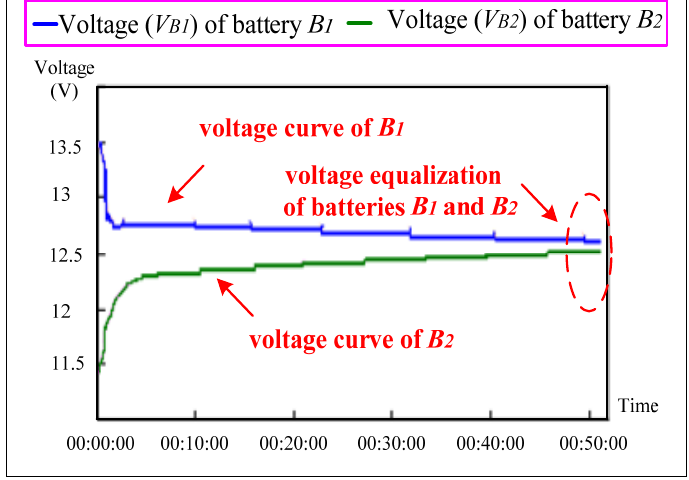
Figure 23. Measured voltage equalization curves of series-connected batteries B